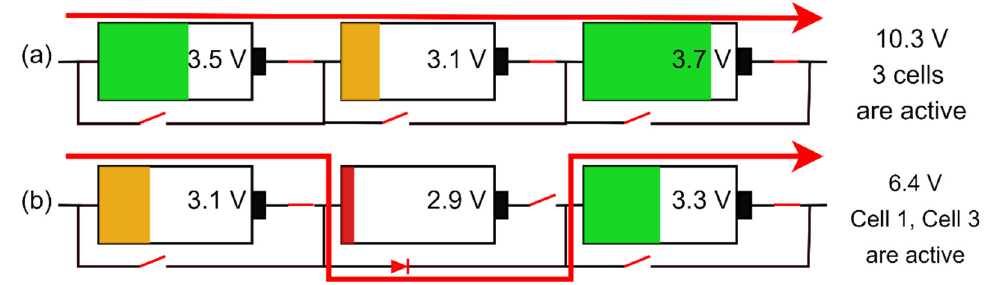
Figure 3. Battery pack configuration examples ( a ) 3 cells active ( b ) 2 cells active.